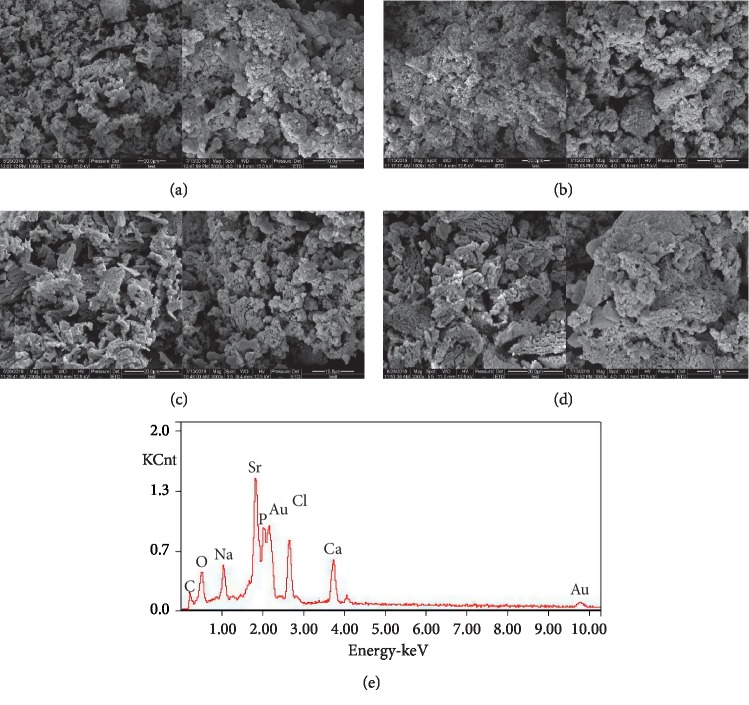
(a)−(d) SEM images of the materials of the Q0, Q1, Q2, and Q3 composite materials, respectively. (e) EDX spectra of the nanoparticles.